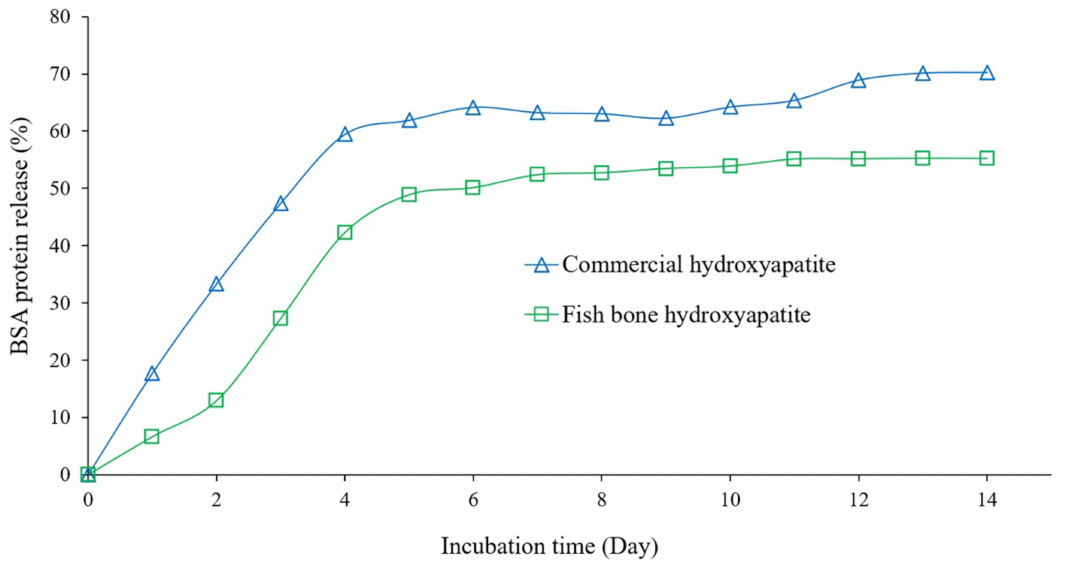
Figure 10. Release amount of the BSA loaded on the commercial and the extracted hydroxyapatite particles at different incubation